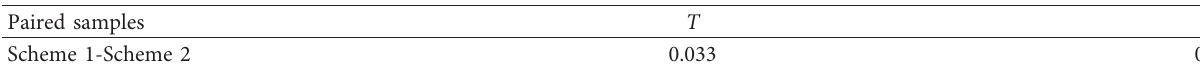
Table 7: Paired sample t -test